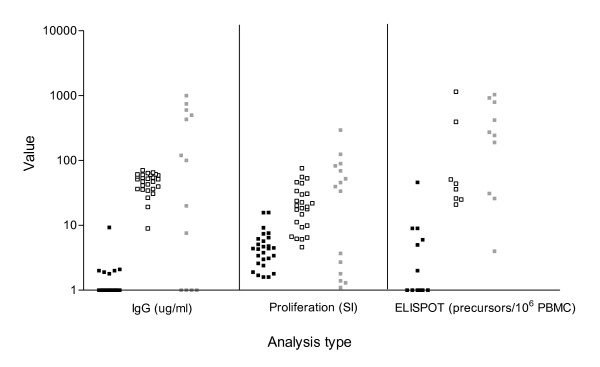
Magnitude of T cell response differs significantly between antigens. Boxes represent responses to the proliferation assay and ELISPOT assay for antigens HER-2/neu (closed boxes), tt (open boxes), and CMV (shaded boxes). Reporting value for the proliferation assay is SI, and reporting value for the ELISPOT assay is antigen-specific precursor/106 PBMC. Antibody immunity for the same group of subjects is shown for comparison, with a reporting value of ug/ml antigen specific IgG.